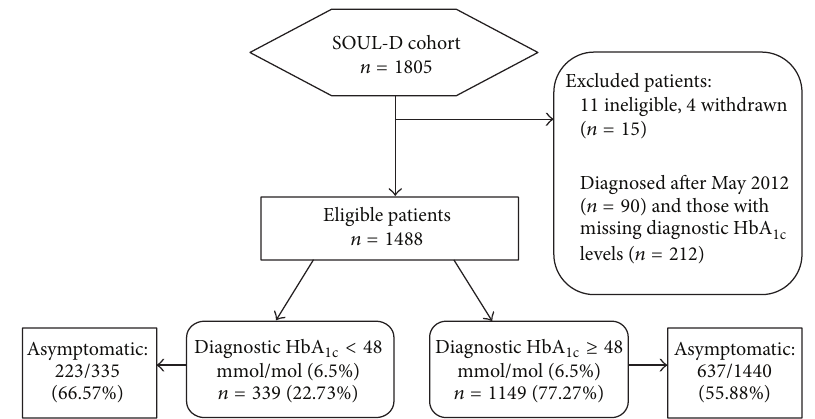
Figure 1: Flow chart for participants in the